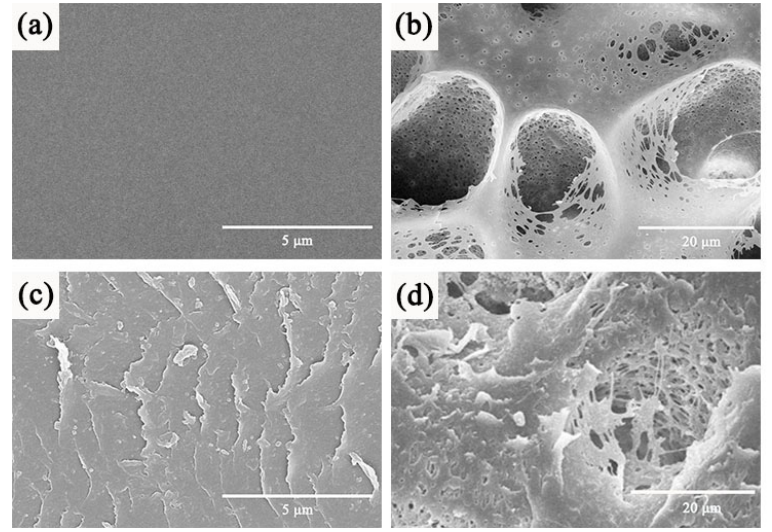
Figure 2. SEM images of the surface of the iPES membrane (( a ), Dense layer; ( b ), Support layer), and iPES/PDA composite membrane (( c ), Dense layer; ( d ), Support layer).